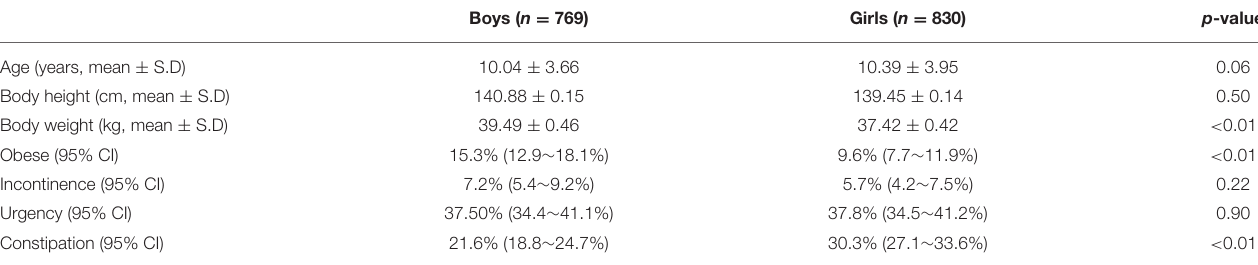
TABLE 1 | Average age and prevalences for obesity, incontinence, urgency, and constipation in boys and girls.